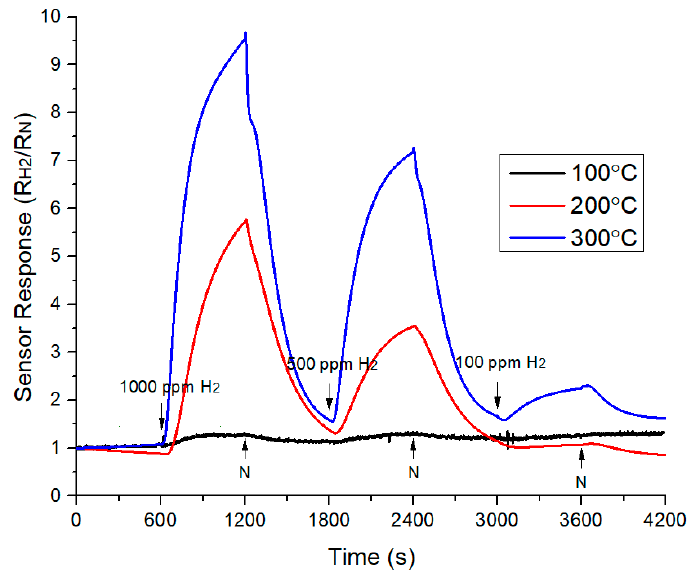
Figure 11. Sensor response of TiO 2 -B 2 O 3 gas sensor at different operating temperature.